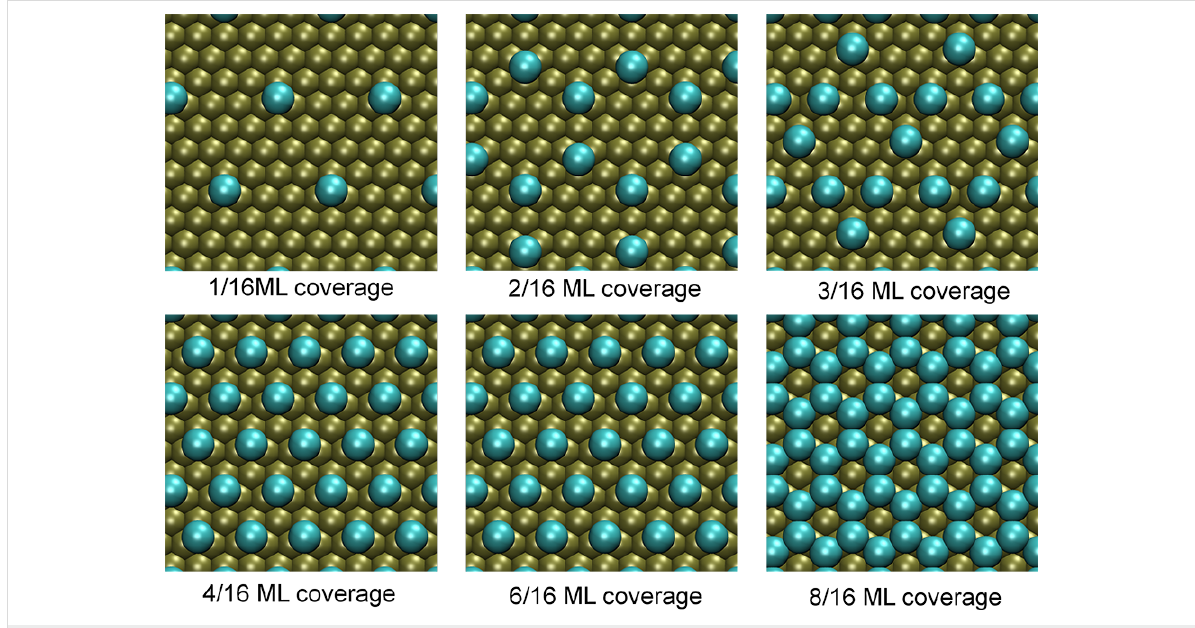
Figure 1: The figures show the relaxed structures of different coverages of chlorine on a Pt(111) surface.